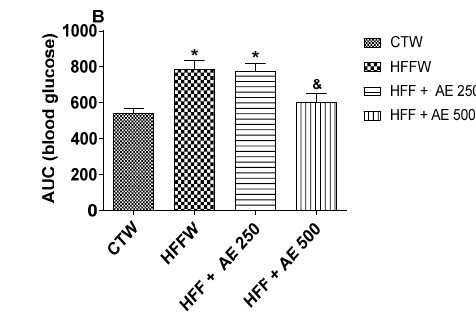
Figure 4. Evaluation of the glycemic profile at the end of the treatment with AE. ( A ) The oral glucose tolerance test at the end of the treatment (16th week); ( B ) the area under the curve (AUC) of the blood glucose of animals evaluated at the end of the treatment (16th week) of CTW (CT + drinking water, n = 11); HFFW (high-fat/high-fructose diet + drinking water, n = 11); HFF + AE 250 (HFF + M. citrifolia fruit aqueous extract of 250 mg/kg of body weight, n = 11); and HFF + AE 500 (HFF + M. citrifolia fruit aqueous extract of 500 mg/kg, n = 10) groups. The results are expressed as the mean ± SEM. * = p ≤ 0.05 vs. CTW. & = p ≤ 0.05 vs. HFFW. Two-way ANOVA, followed by the Bonferroni post-test for the oral glucose tolerance test. ANOVA, followed by the Tukey post-test for the AUC.